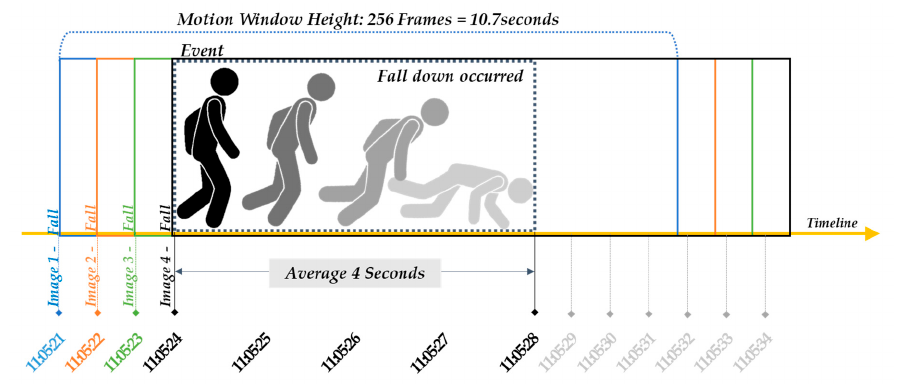
Figure 7. Labeling method considering motion window size and behavior type information.